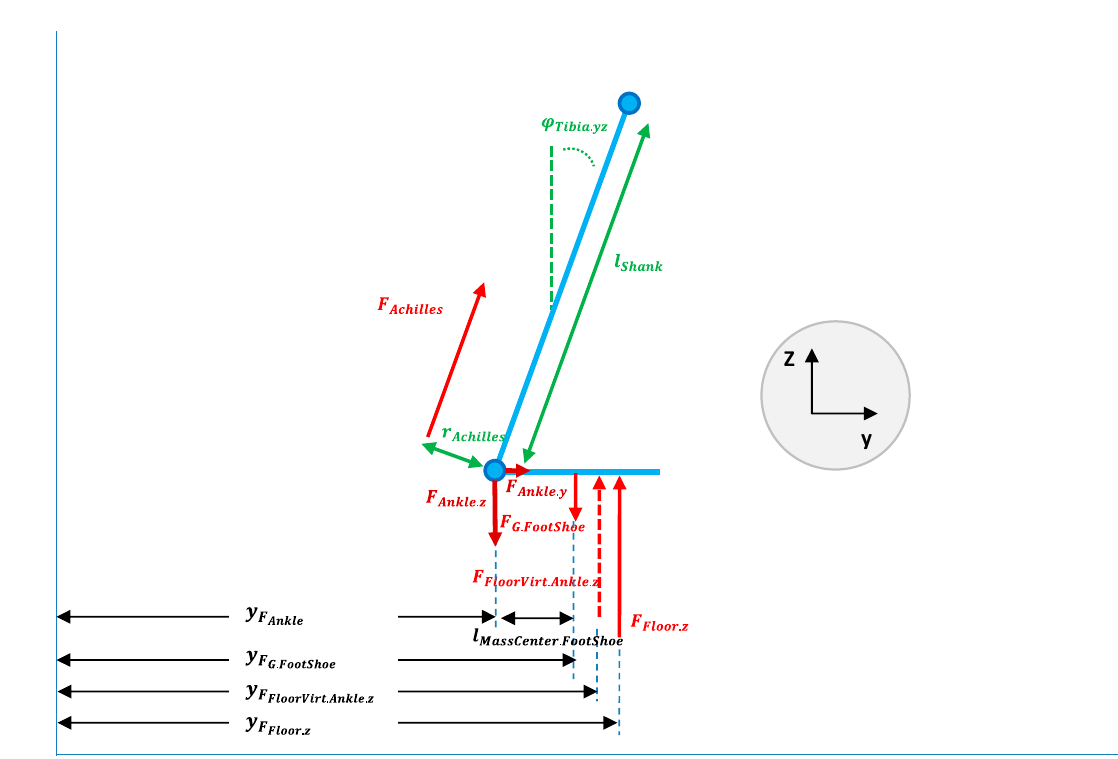
Figure A1. Calculation of ankle joint forces.